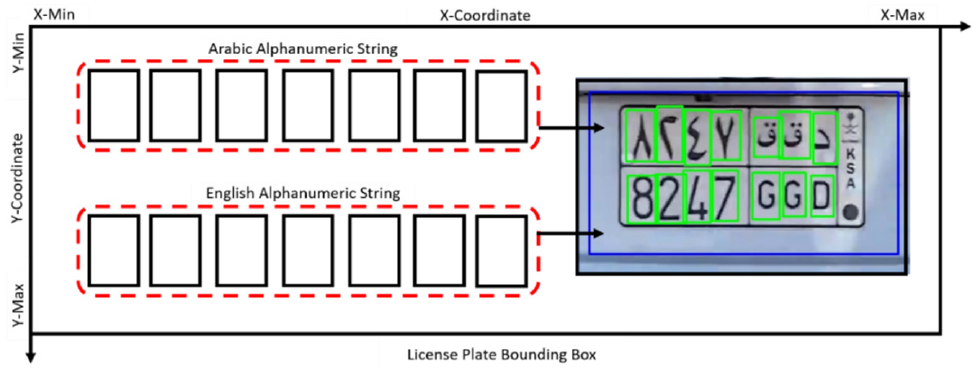
Figure 9. Location-based approach for discarding Arabic text.